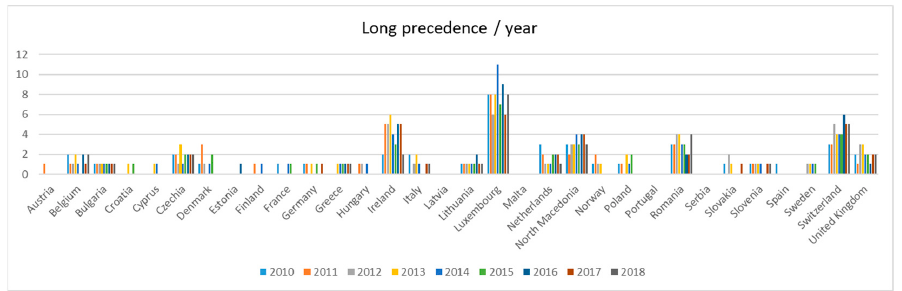
Figure 8. Number of long precedence by country, 2010–2018—geospatial distribution.